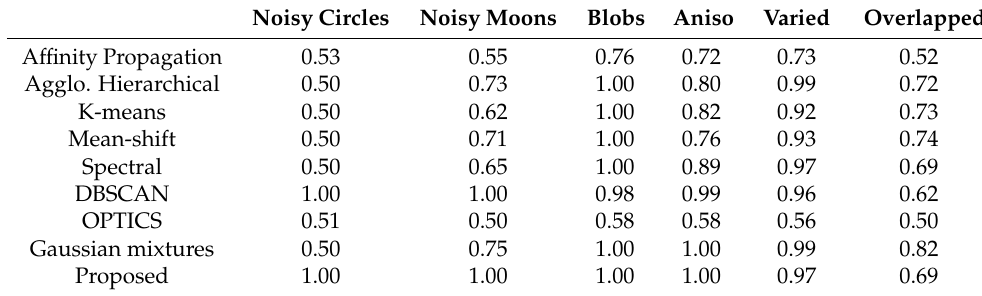
Table 2. The RI of affinity propagation, agglomerative hierarchical, k-means, mean-shift, spectral, DBSCAN, OPTICS, Gaussian mixtures, and the proposed clustering methods on noisy circles, noisy moons, blobs, anisotropic, varying variance, and overlapping datasets. Noisy